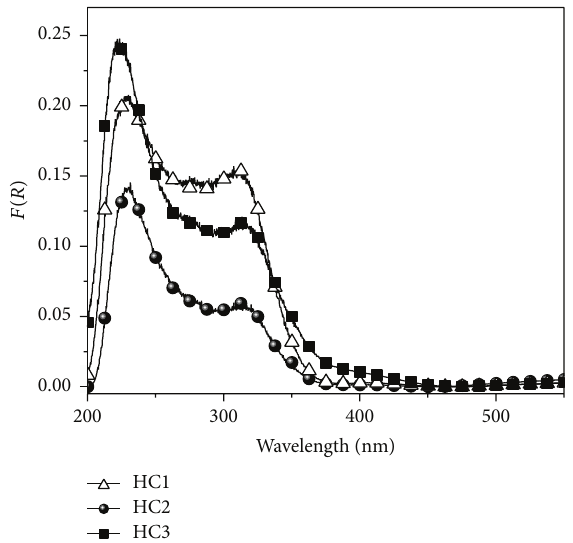
Figure 7: UV-Vis spectra of the calcined samples at 700 ∘ C.